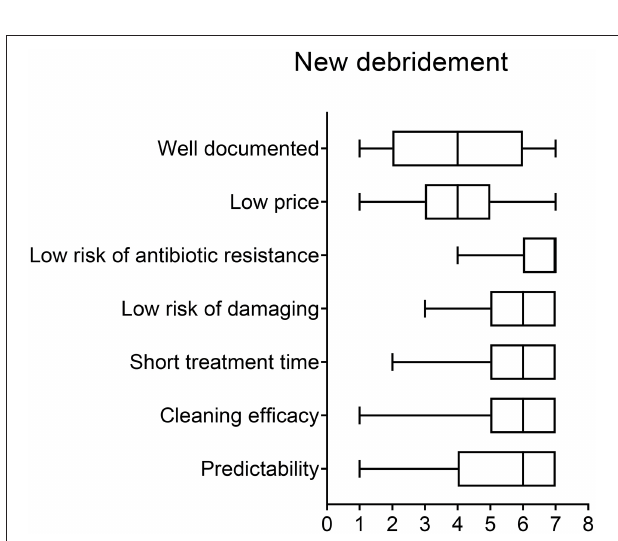
FIGURE 11 | Need from new therapies for peri-implantitis and peri-implant health